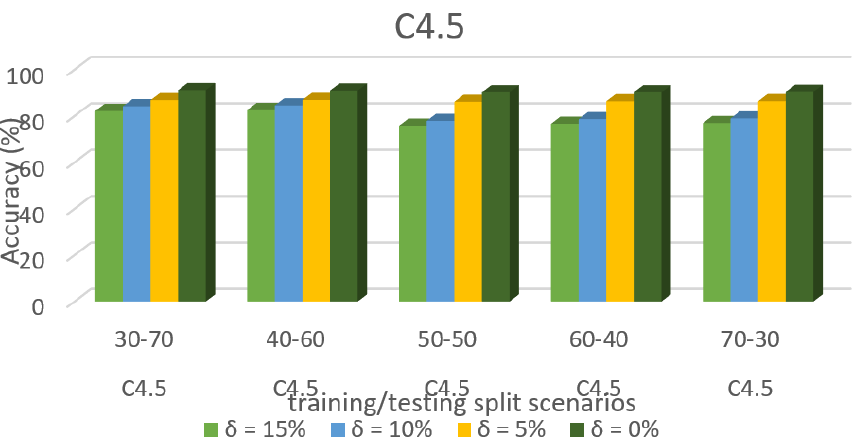
Figure 14. Accuracy Prediction for Dataset 2 using the C4.5 Algorithm.